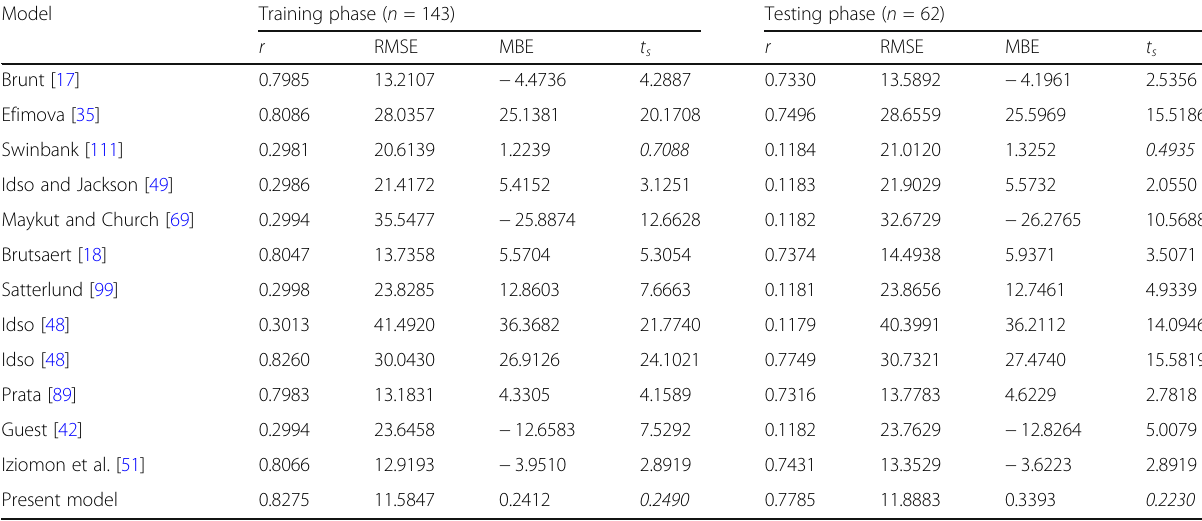
Table 3 Statistical results for regression models ’ estimations of cloudless DLR and the statistically significant models are in italics